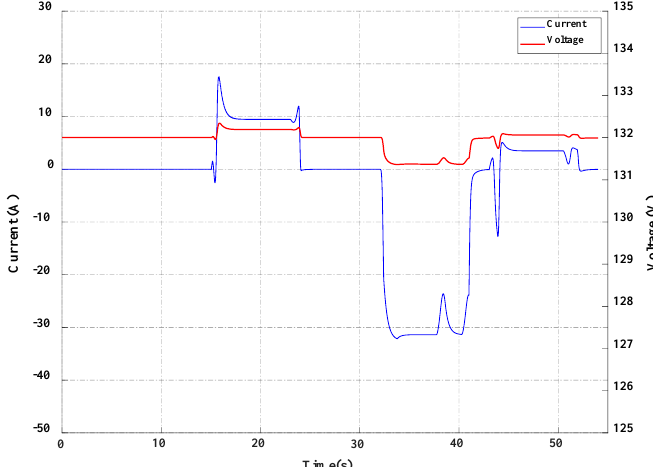
Figure 14. Voltage and current of the battery. The potential energy can be calculated as shown in Equation (3).